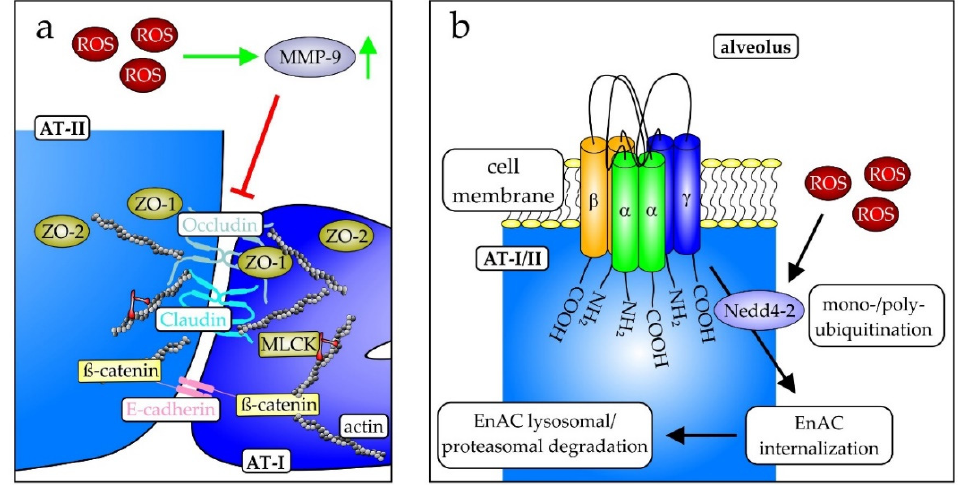
Figure 4. Important structures in alveolar epithelial cells. ( a ) The connection between alveolar type I and type II cells is mediated by occludin and claudin, two proteins involved in the formation of tight junctions, and the calcium-dependent cell adhesion protein epithelial (E)-cadherin. These proteins connect cells to the intracellular actin filaments and downstream signaling cascades as exemplified by the myosin light chain kinase (MLCK) via β -catenin and the zona occludens proteins ZO-1 and ZO-2 (mod. from [117]). ( b ) The epithelial sodium channel (ENaC) is a multimeric protein complex localized in the cell membrane of the pulmonary AT-I and -II cells. It consists of the three homo-dimeric subunits αα , ββ , and γγ and is an important mediator of pulmonary edema clearance and is expressed in two isoforms. One is highly Na + selective, whereas the other is a cation-nonselective form. During ARDS, several mechanisms provoke downregulation of ENaC expression, apical localization, and activity. ENaC is downregulated by internalization and proteasomal or lysosomal degradation, following Nedd4-2-dependent mono- or poly-ubiquitination. During infection, the downregulation of inflammatory cytokines TNF- α , TGF- β , IL-4, IL-13, and IL-1 β contributes to this [mod. from